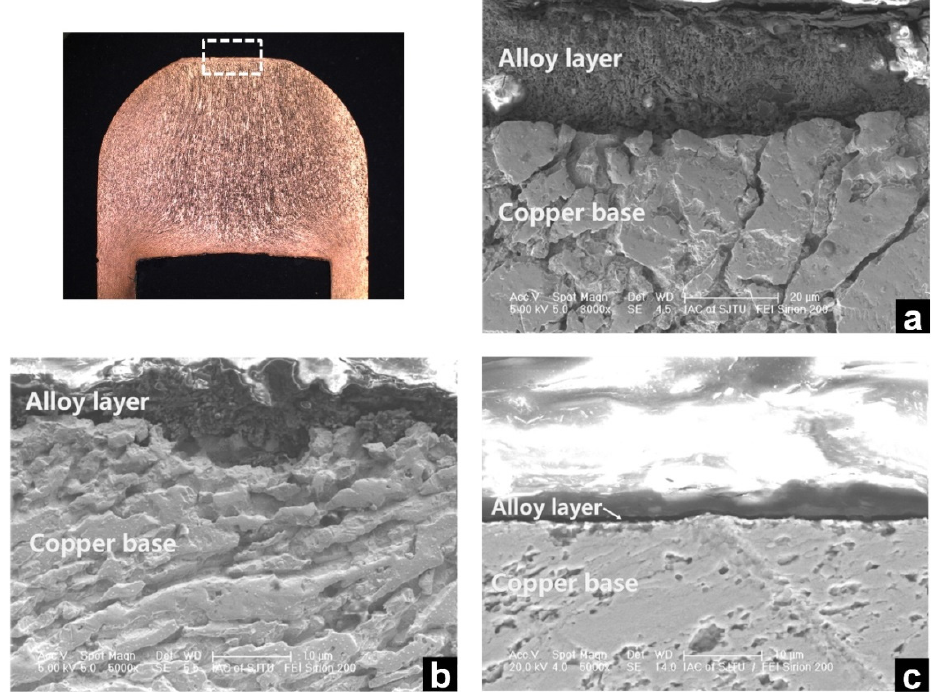
Figure 16. Cross-sections of the electrodes used after 600 welds, ( a ) no strip; ( b ) 0.10 mm AISI304 strip; and ( c ) optimized strip[4]. Reprinted with permission.